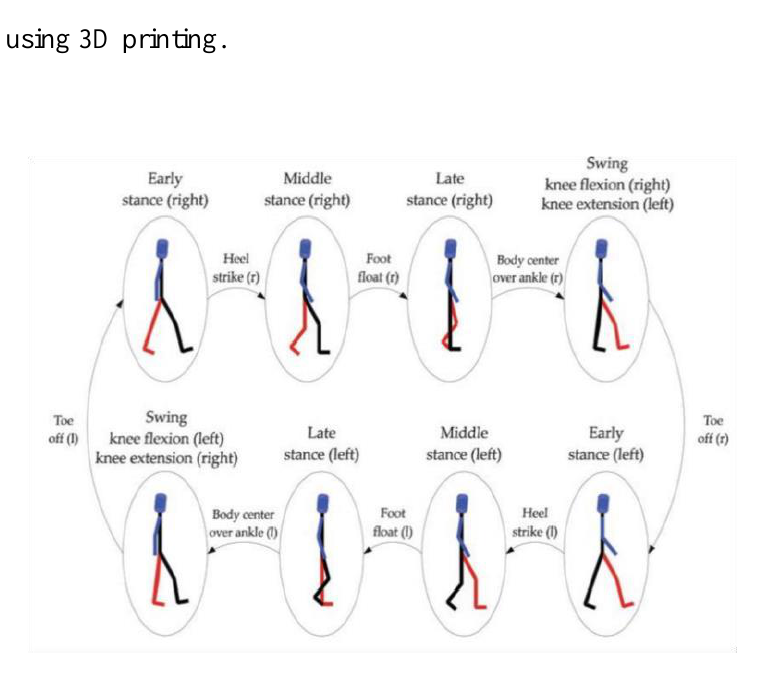
Figure 6. Leg movement for